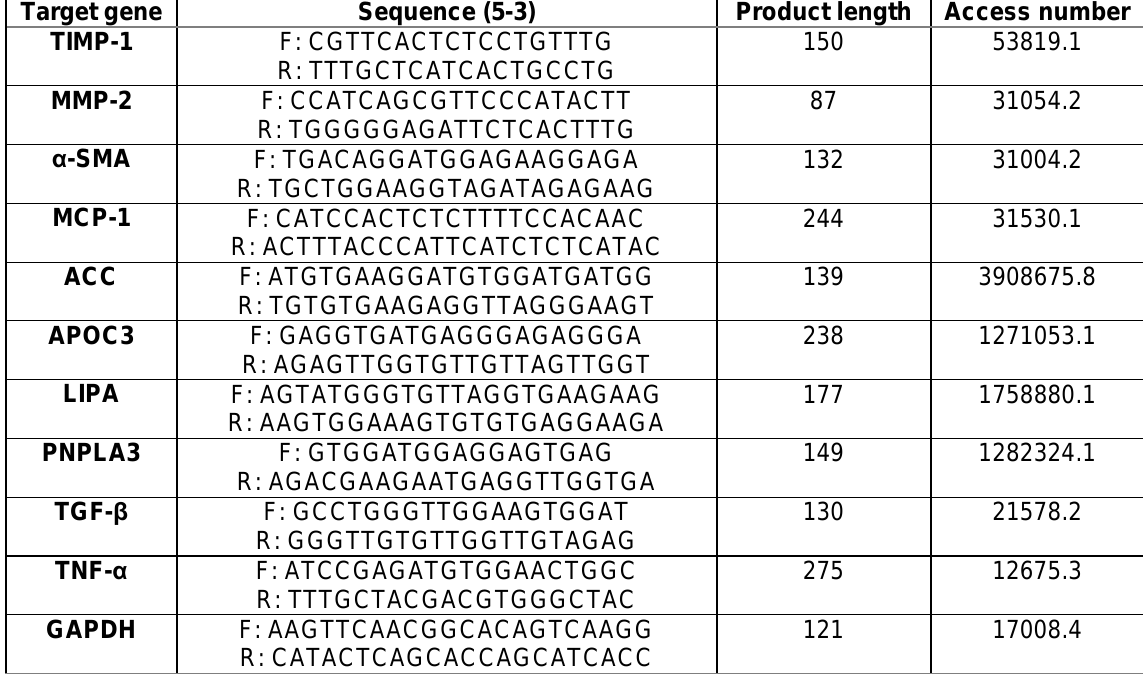
Table 1: Sequences of oligonucleotides used as primers Target